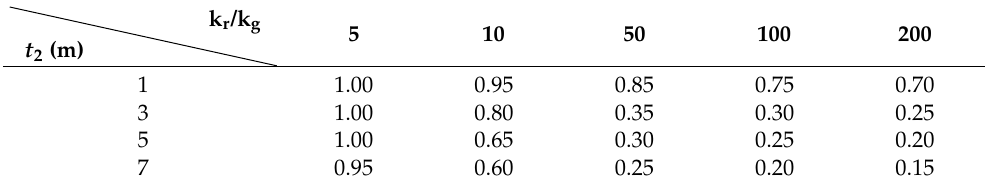
Table 6. Recommended value of water pressure reduction coefficient of class C surrounding